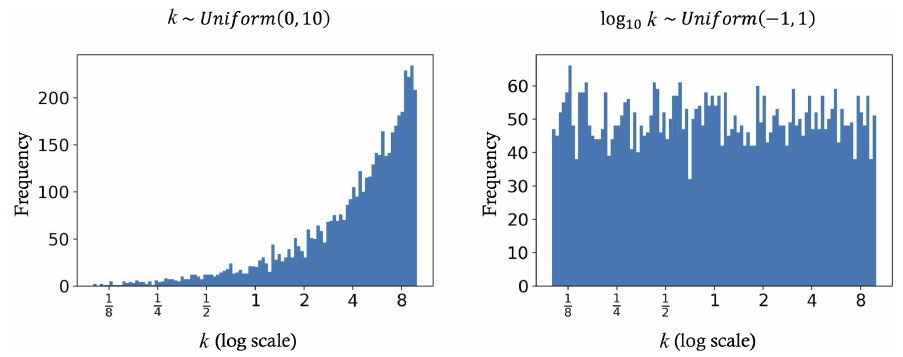
Figure 8. The comparison between drawing the scaling factor k from the straightforward uniform distribution ( left ) and from our proposed distribution ( right ).